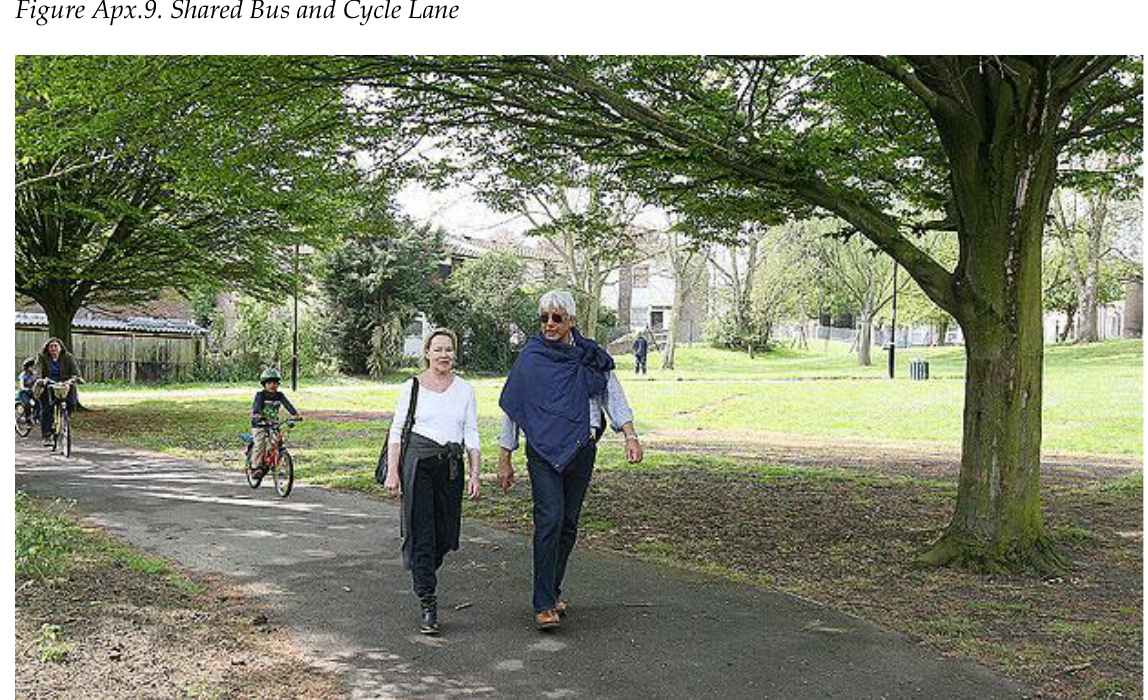
Figure Apx.10. Shared Park